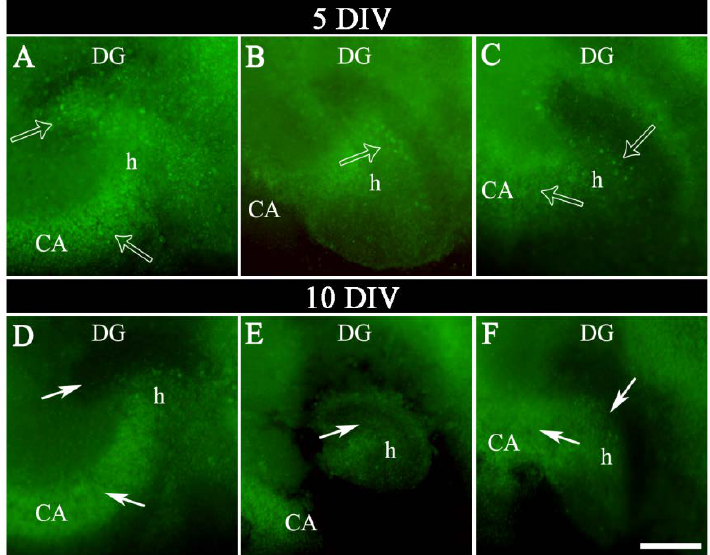
Figure 4. Photomicrographs of hippocampal slices from Chips 1, 2, and 3 illustrating in greater detail the different patterns of OGB marker in CA, DG, and h, at 5 DIV ( A – C ) and 10 DIV ( D – F ). Note the evident changes in the OGB labeling distribution between 5 and 10 DIV. A dense dot-shaped labeling, corresponding living cells (open arrows) was scattered through whole hippocampal formation, at 5 DIV (medium phase) ( A – C ). By contrast, at 10 DIV there was a sharp decrease labeling with partial or total lack of OGB labeled cells (white solid arrows) in some zones of CA, DG, and h (late phase) ( D – F ). CA, cornu Ammonis subfield; DG, dentate gyrus; DIV, days in vitro; h, hilus. Scale bar shown in F indicates 270 µm in ( A – F ).